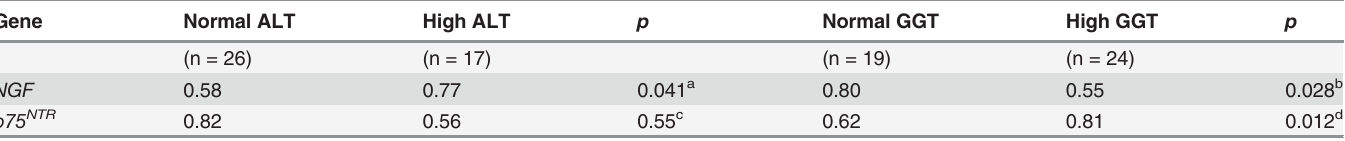
Table 2. Comparison of median values of relative NGF and p75 NTR gene expression with serum levels of liver enzymes in individuals with and with- out HBV and HCV, with different degrees of the disease.